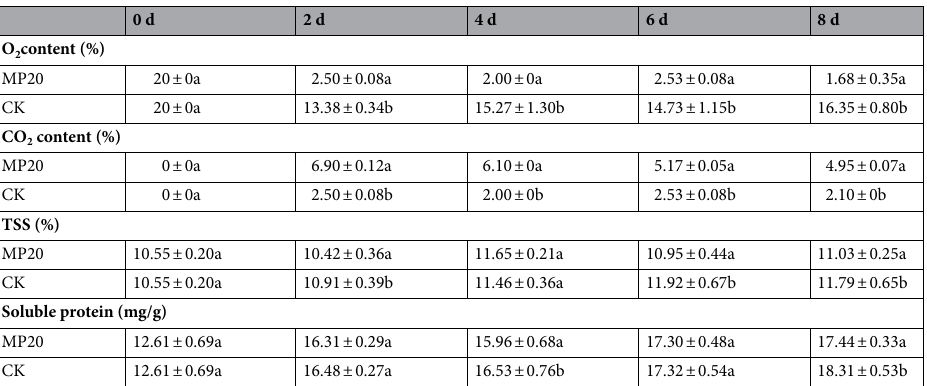
Table 1. The gas composition, soluble solids (TSS) and soluble protein of mulberry leaf vegetable in two packaging during storage. Each datum is the means and standard deviation (n = 3). MP20 modified polyethylene packaging, CK normal polyethylene packaging. Different letters (a, b) represent significant difference at p < 0.05 level with the same row between different